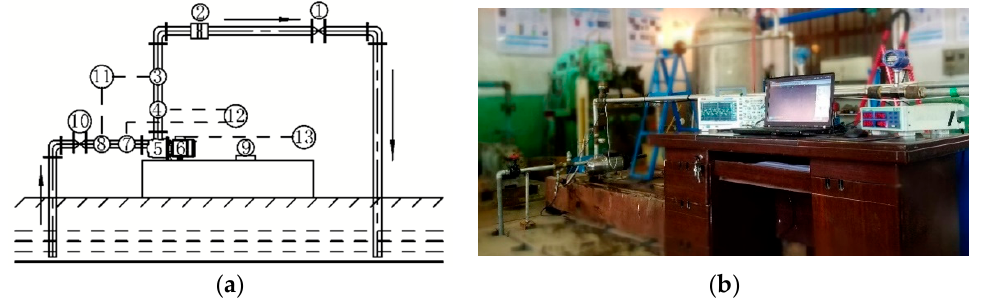
Figure 4. Test system. ( a ) Schematic diagram of the test system structure; ( b ) test site. 1: Valve at pump